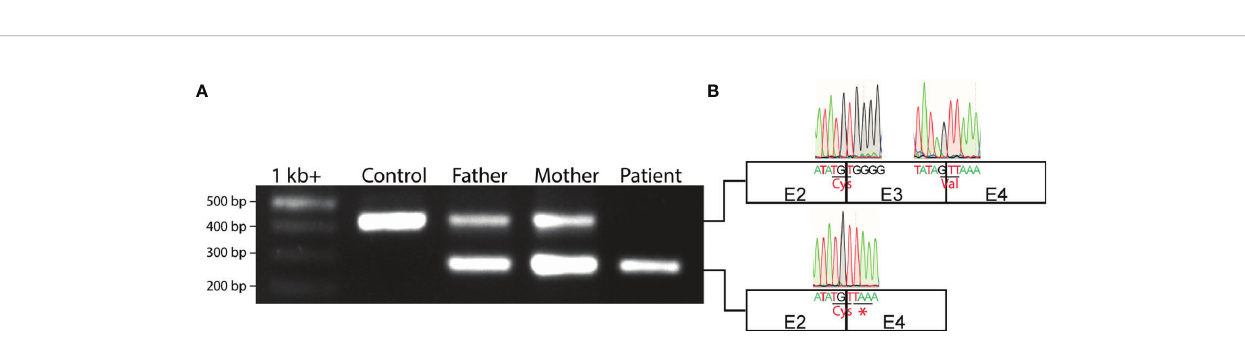
FIGURE 3 | Aberrant IL7RA mRNA splicing in the patient. (A) PCR of exons 2-4 of IL7RA cDNA in the patient, parents, and a control. (B) Schematic representation of exons 2-4, and Sanger sequencing chromatograms of the exon junctions obtained from the PCR products. Shown are the last 5 nucleotides at the 5 ’ and 3 ’ ends of each exon with the respective chromatogram. Shown also are the amino acids encoded by the junctional codons, and the STOP codon that results from the alternative splicing of exon 2 to 4 in the patient. E, exon; Cys, cysteine; Val, valine; *, STOP codon.